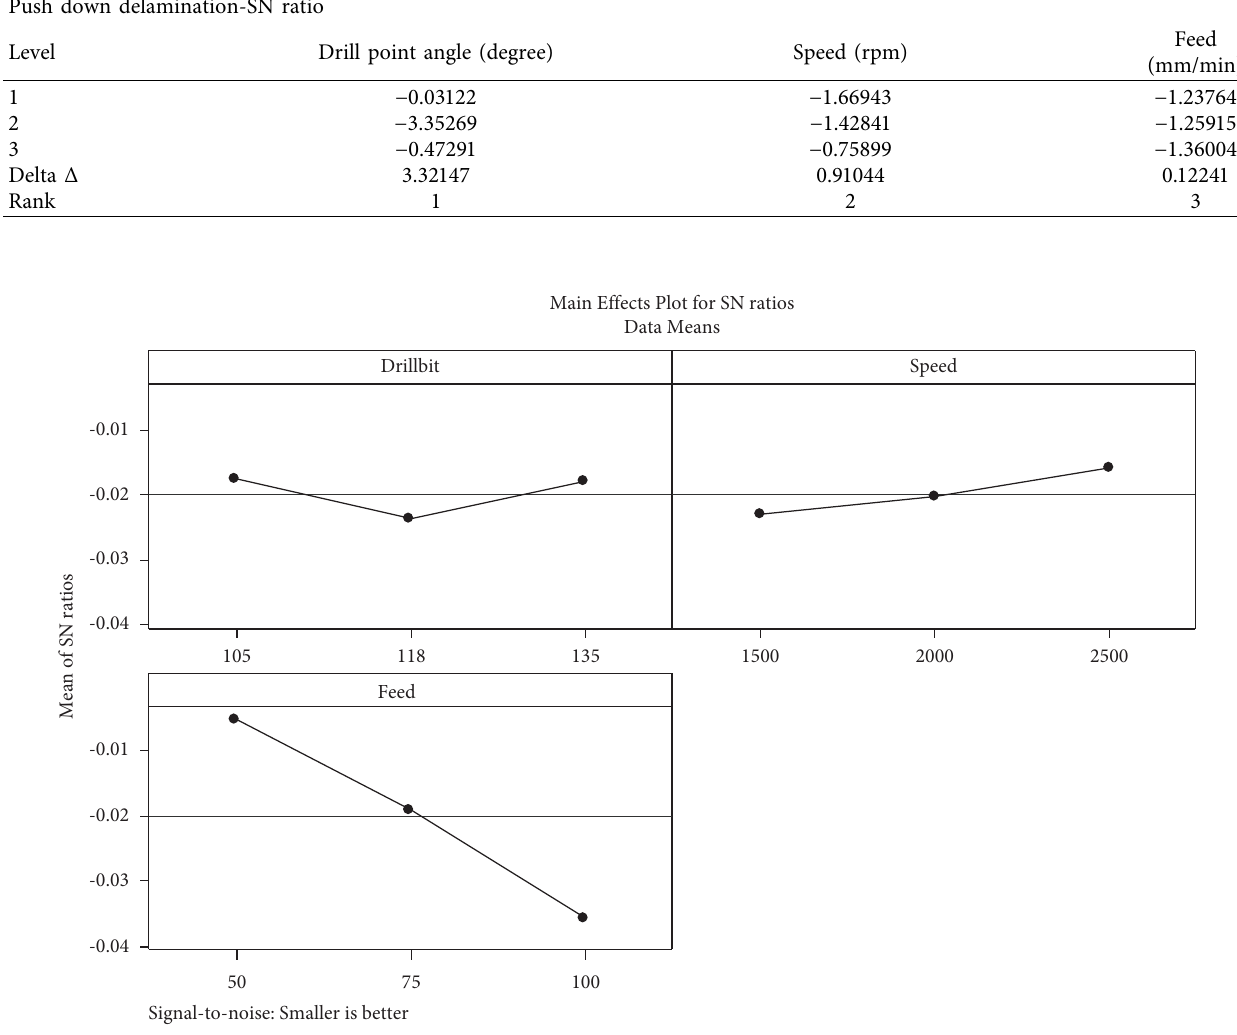
Figure 6: Plot of SN ratios’ key efects-peel up